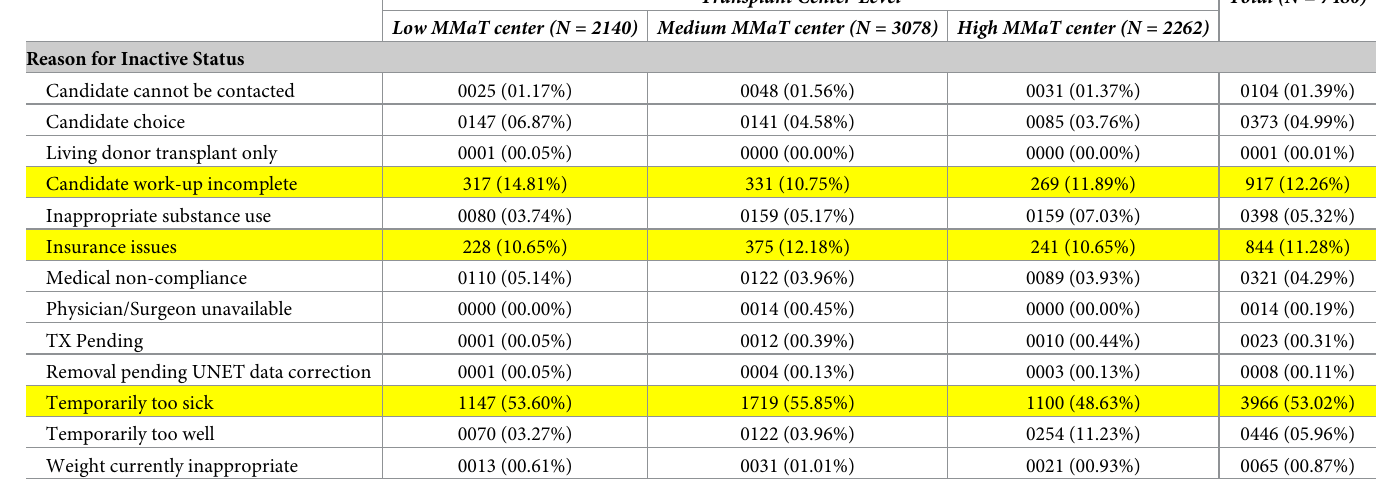
cant difference in inactive to active transitions across MMaT tertiles.